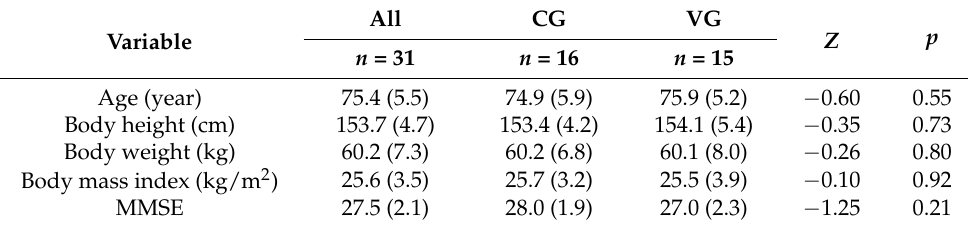
Table 1. Comparisons of Demographic Characteristics Between